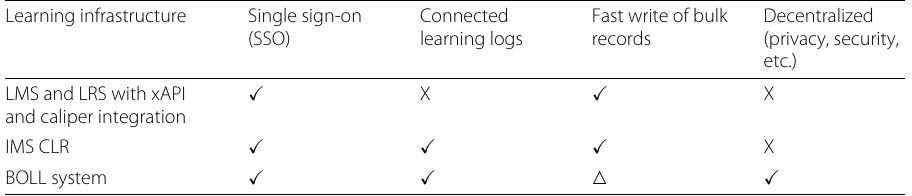
Table 8 Comparison of BOLL system to other learning infrastructure Learning infrastructure Single sign-on